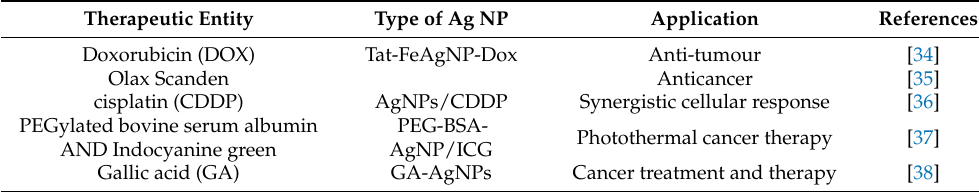
Table 4. Types of AgNPs and their applications in cancer